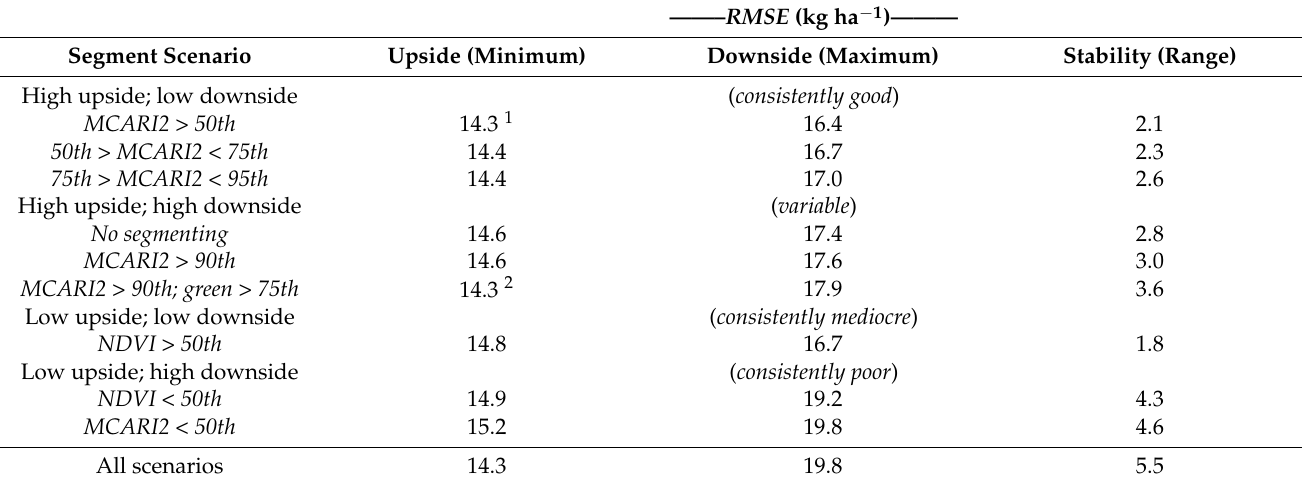
Table 3. Minimum, maximum, and range of nitrogen uptake root mean squared error ( RMSE ) for each of the processing scenarios at the segment step. The scenarios are grouped by their relative upside (greater potential for low error) and downside (greater potential for high error) characteristics. Stability (range) refers to the consistency in RMSE values (across workflow scenarios).